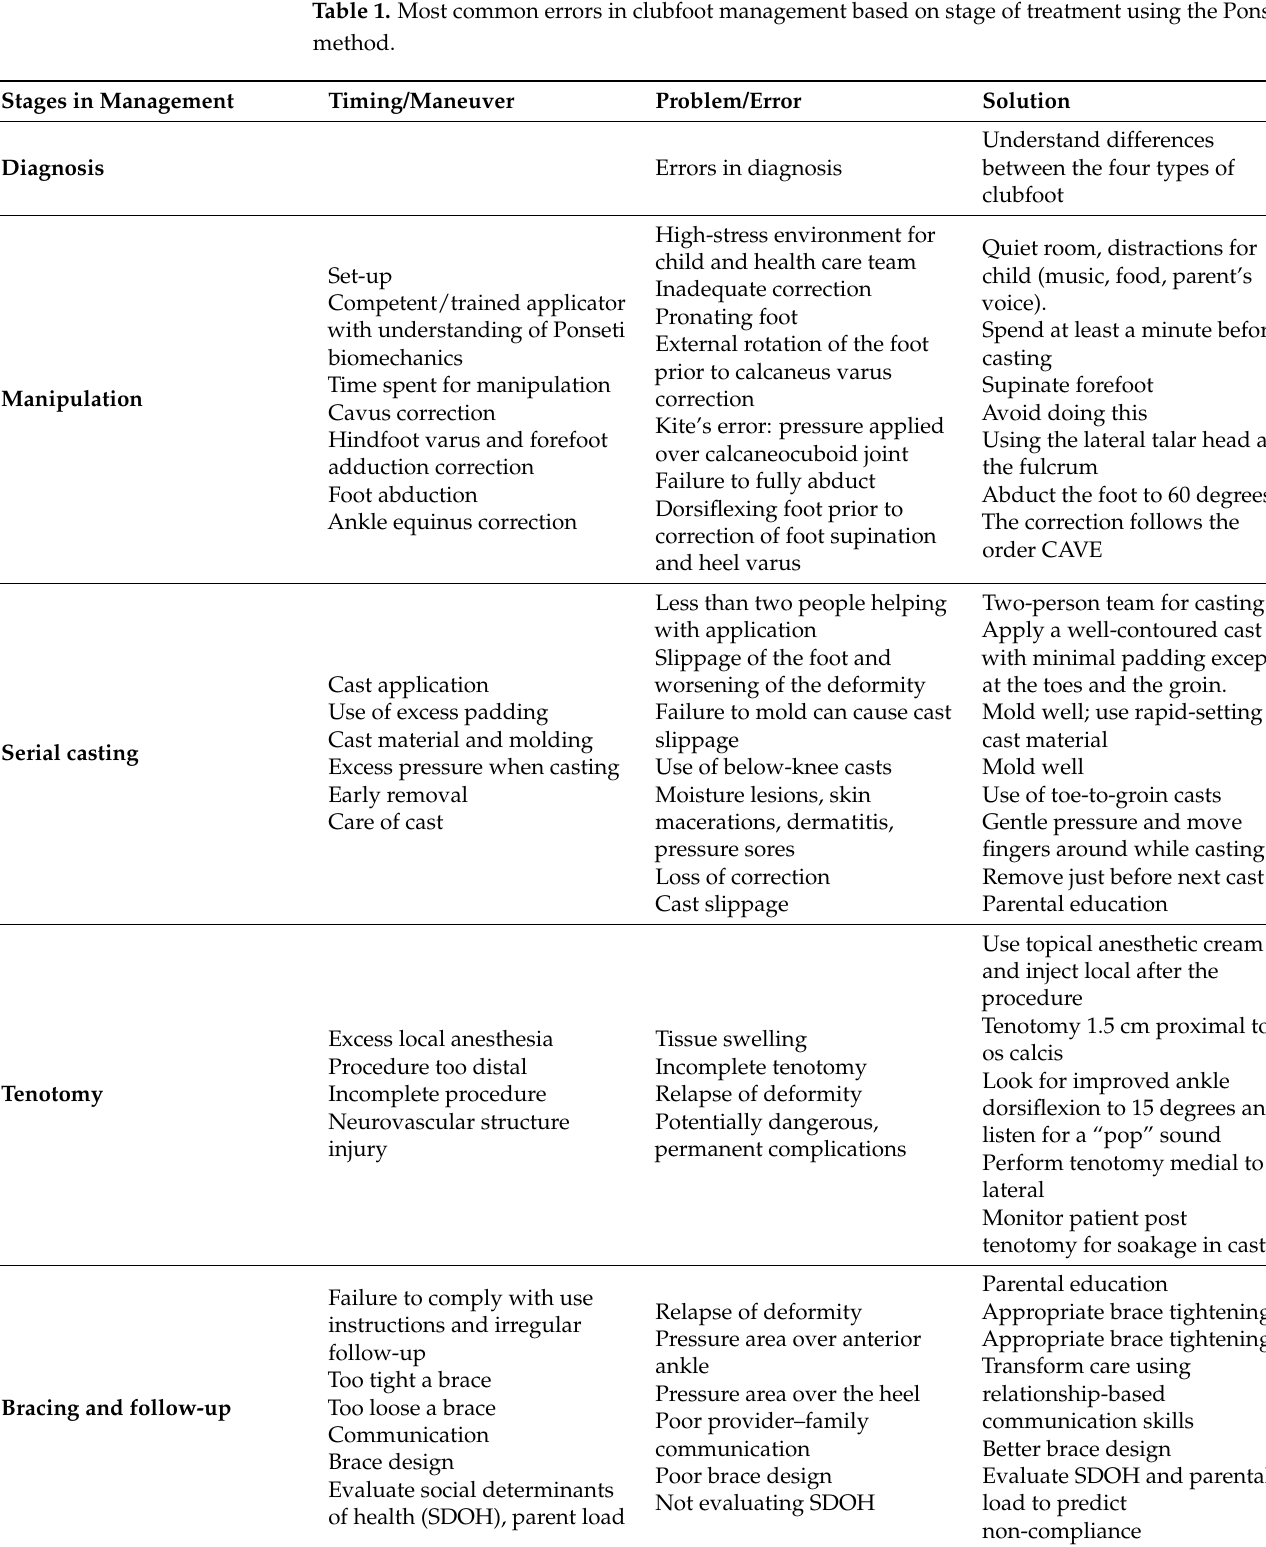
Table 1. Most common errors in clubfoot management based on stage of treatment using the Ponseti